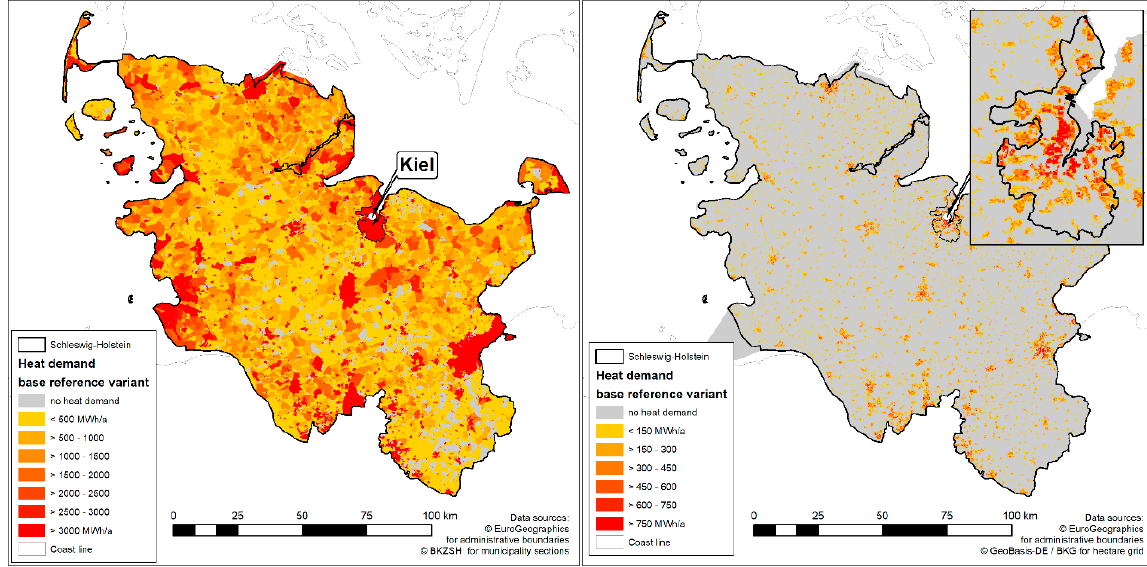
Figure 4. Heat demand of residential buildings modeled without information on construction period mapped on munici- pality sections ( left ) and hectare grid cells ( right ) for the study region Schleswig-Holstein and the municipality area of the City of Kiel.